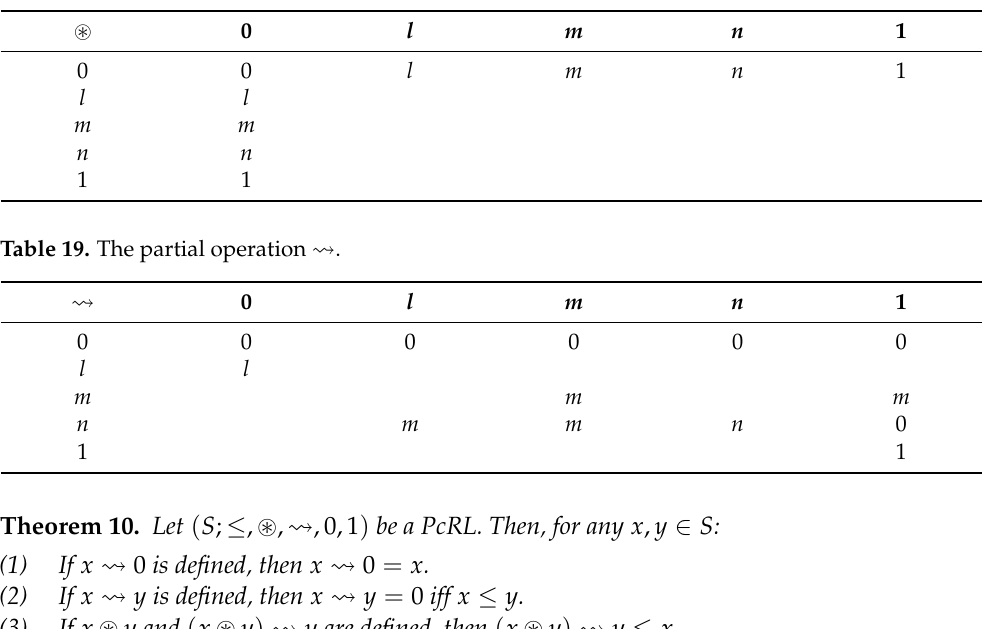
Table 18. The partial operation (cid:126) .